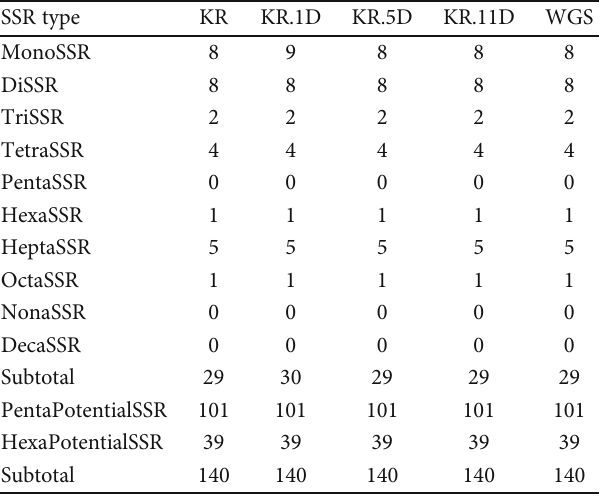
Table 6: List of SSRs identi fi ed from the fi ve fungal mitogenomes of WBPH